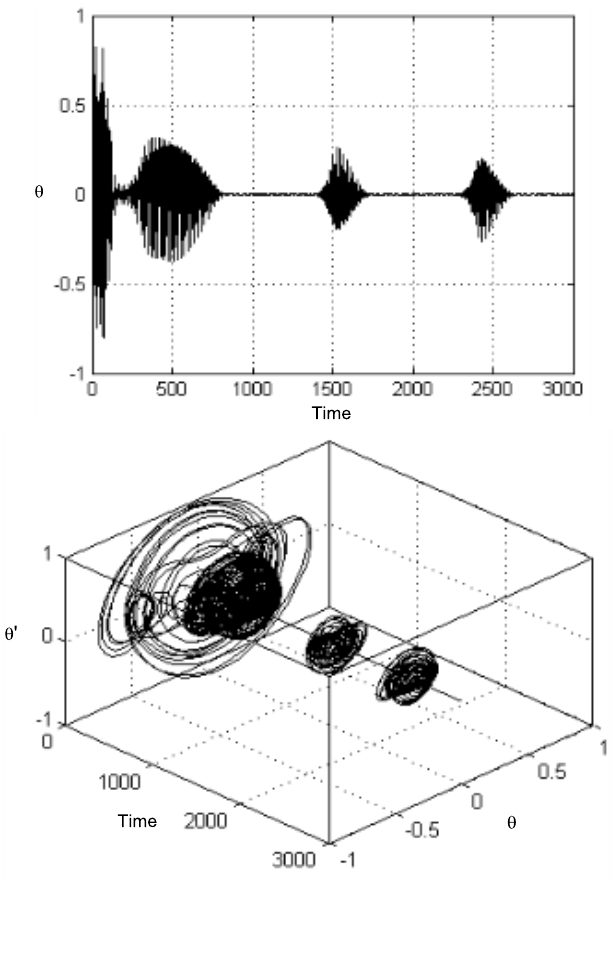
Figure 11. Time history and three-dimensional ( θ, θ (cid:48) , T ime ) plot for intermittent-type